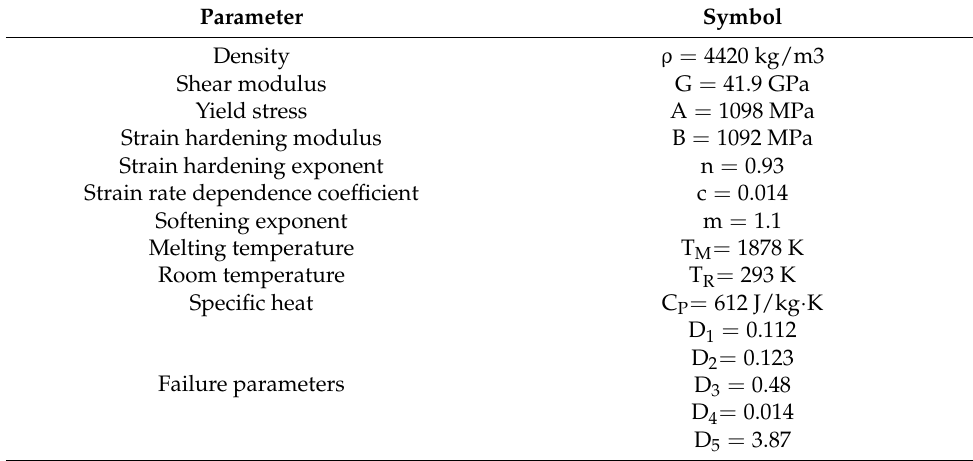
Table 2. Johnson-Cook material parameters for Ti-6Al-4V.